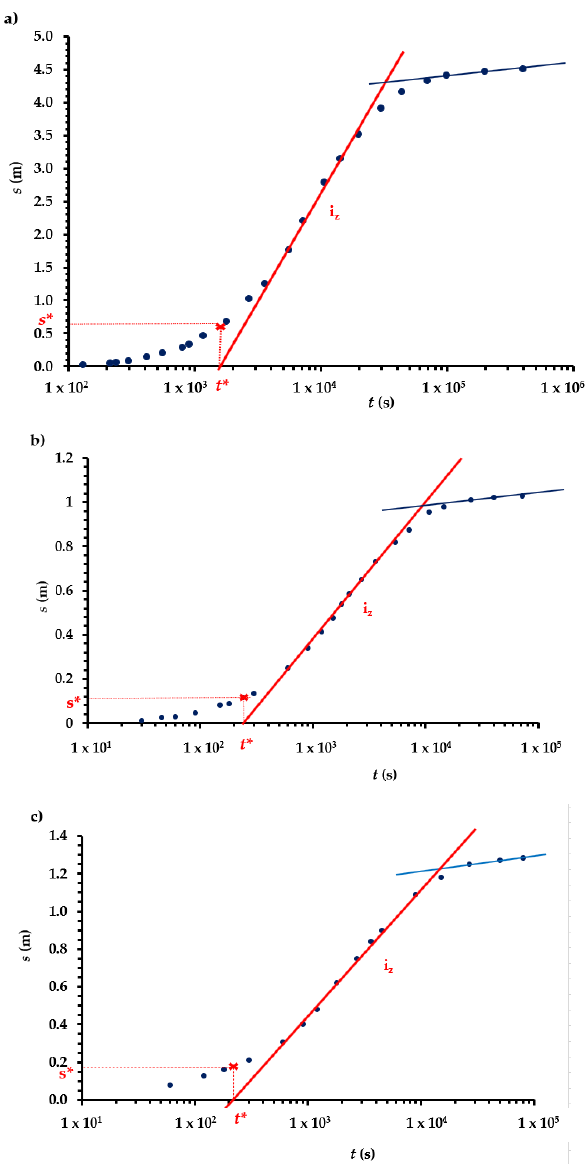
Figure 12. Semilogarithmic graphs of the pumping tests on the S-V well ( a ) before rehabilitation, ( b ) after rehabilitation, and ( c ) one year after rehabilitation. ( b ) after rehabilitation, and ( c ) one year after